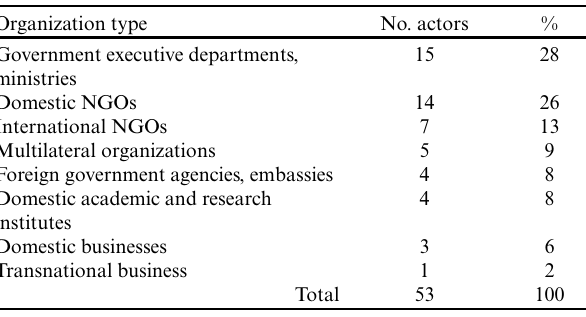
Table 1 . Organizational composition of the REDD+ policy actors in Tanzania in